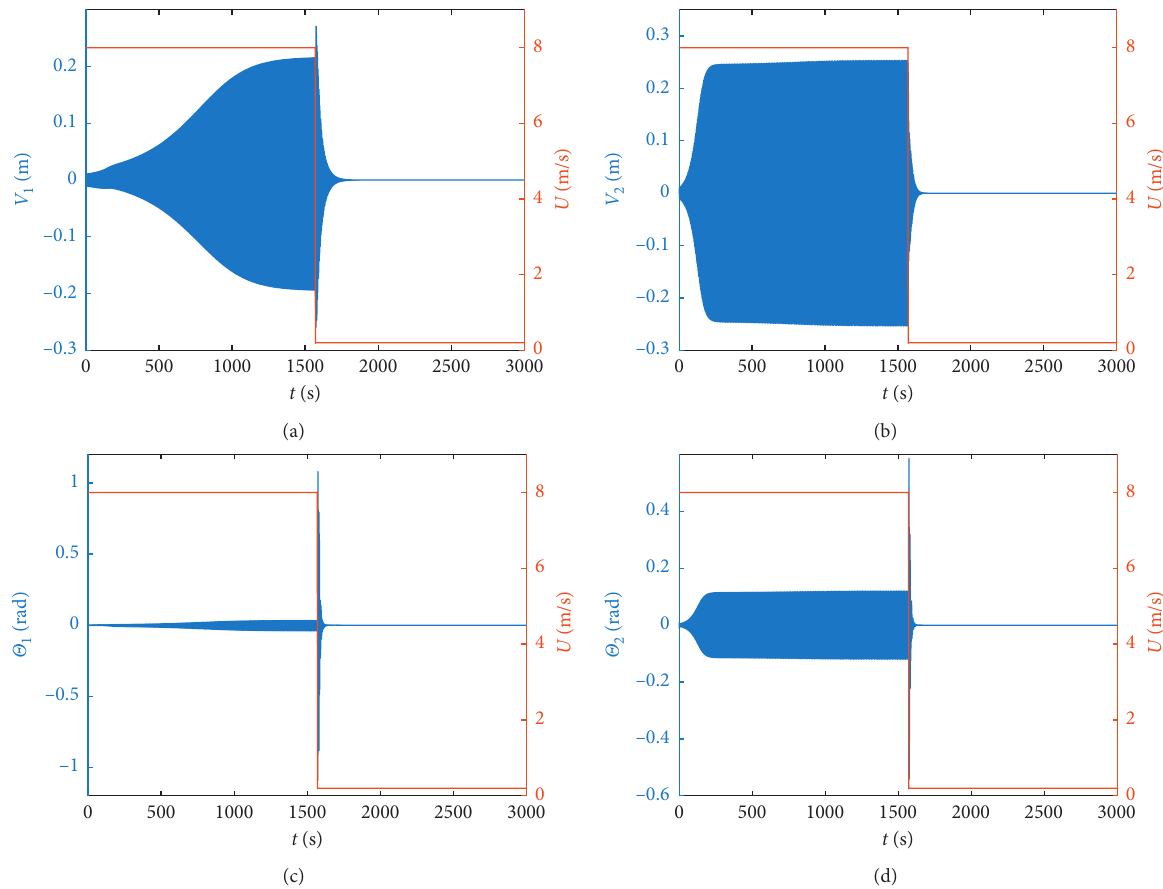
Figure 3: Time histories (0–3000 s). (a) 1 st in-plane mode. (b) 2 nd in-plane mode. (c) 1 st torsional mode. (d) 2 nd torsional mode.